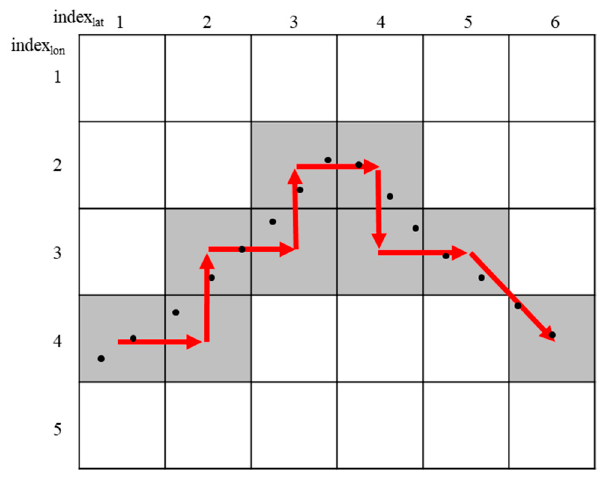
Figure 4. Grid-based path identification by user points.